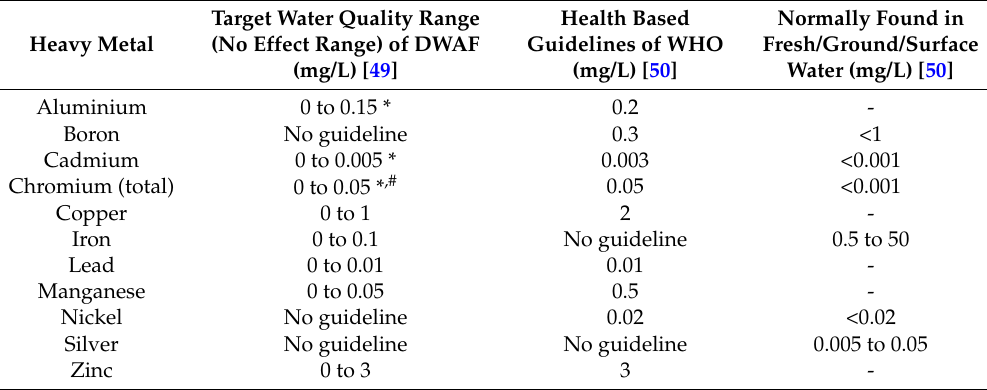
Table 2. Drinking water guidelines of South Africa and World Health Organization (WHO).